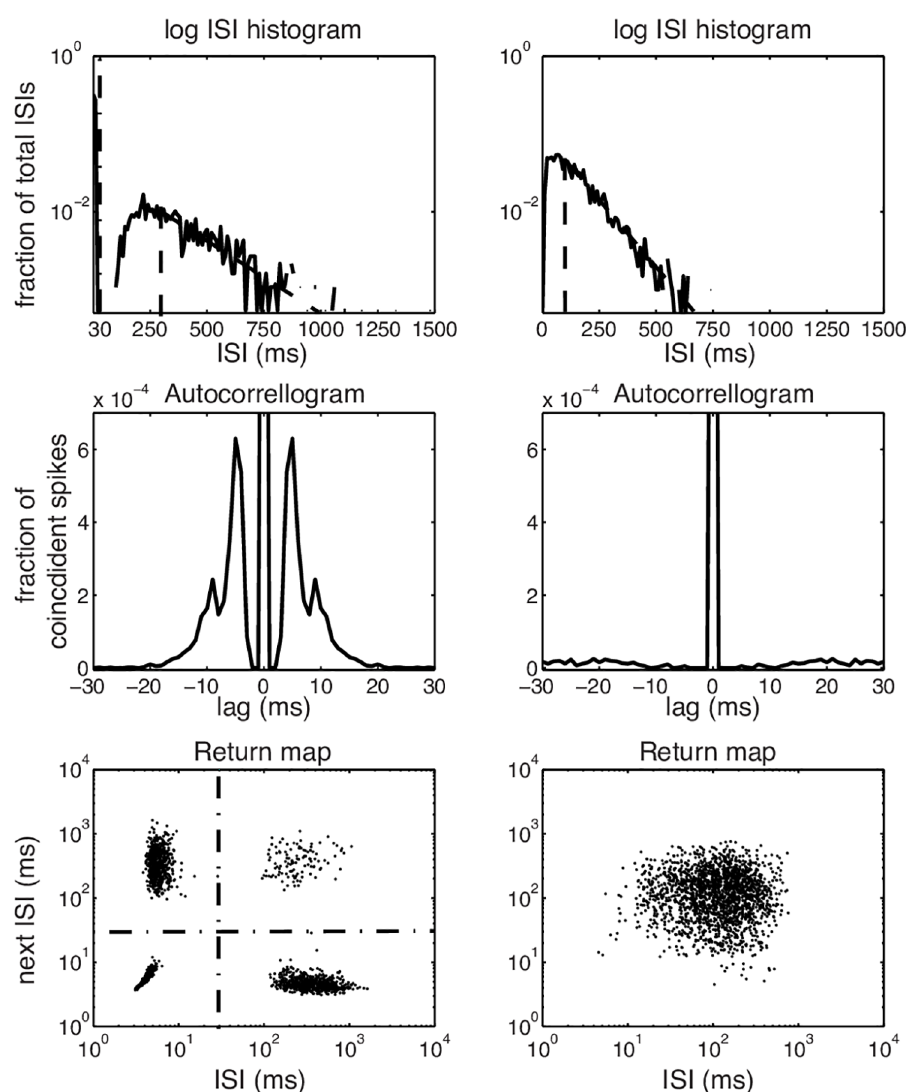
Fig 2. Quantification of burstiness in a TCR cell spike train. Left panels: Spike train recorded at a membrane state of − 80 mV. The ISI histogram (top row) shows a first peak around 5 ms and a second one around 250 ms. The tail decays exponential (dashed line) above 300 ms; so events were considered independent if further apart than 300 ms. The Autocorrelogram (middle row) shows peaks at 5 and 10 ms. In the return map (bottom row) ISI n is plotted against ISI n+1; k-means clustering of this data provides 4 clusters and a silhouette value of 0.96. Based on the ISI histogram and the return map we used an interval of 30 ms to separate single spikes from bursts. Right: Spike train recorded at a membrane state of −50 mV. The ISI histogram (top row) indicates a single Poisson process with events independent if they were further apart than 100 ms. The autocorrelogram (middle) shows only one central peak around zero and the return map (bottom) shows an unimodal structure confirmed by a silhouette value of 0.48.